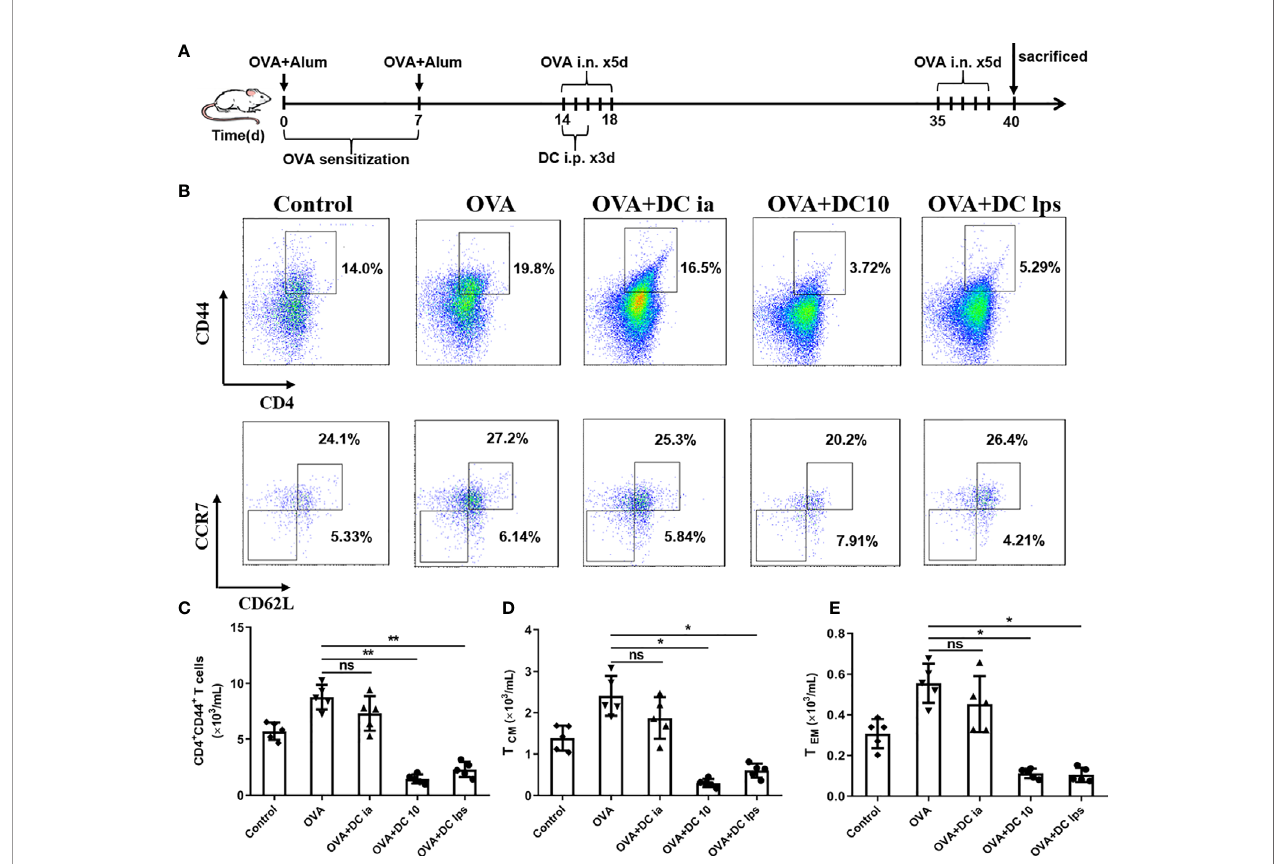
FIGURE 4 | Adoptive transfer of DClps reduced the number of pulmonary memory CD4 + T cells. (A) Schematic of the OVA-induced asthmatic mouse model. The general experimental design is described in the main text. (B) Analysis of pulmonary memory CD4 + CD44 + T cells by FCM. Central memory CD4 + T cells (T CM ) were determined as memory CD4 + CD44 + CD62 + CCR7 + T cells. Effector memory CD4 + T cells (T EM ) were determined as memory CD4 + CD44 + CD62L − CCR7 − T cells. (C) Cell numbers of memory CD4 + CD44 + T cells sorted by FCM in each group. (D, E) Cell numbers of T CM and T EM sorted by FCM in each group. The columns and error bars represent the mean and SEM. (*P < 0.05, **P < 0.01, ANOVA with Tukey ’ s post hoc analysis). The same experiment was repeated three times with similar results (n = 5 in each